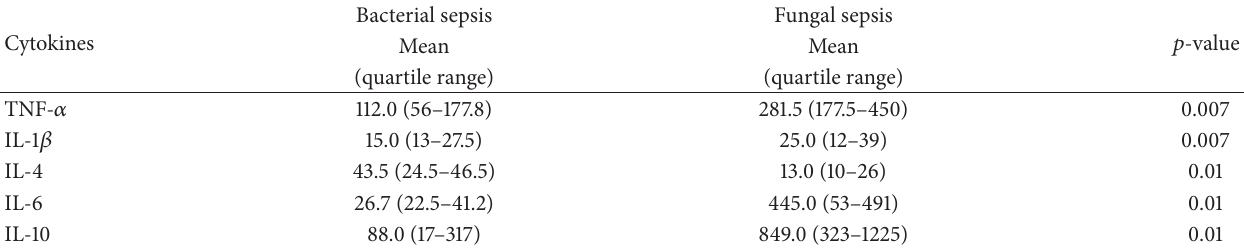
Table 3: Serum cytokine level (pg/mL) in confirmed bacterial and fungal neonatal sepsis (mean; quartile range).